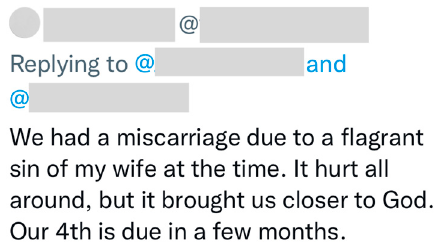
Figure 7. Tweet by a married man. 19 February 2023. Figure 8. Tweet by a married man. 19 February 2023. Twitter.